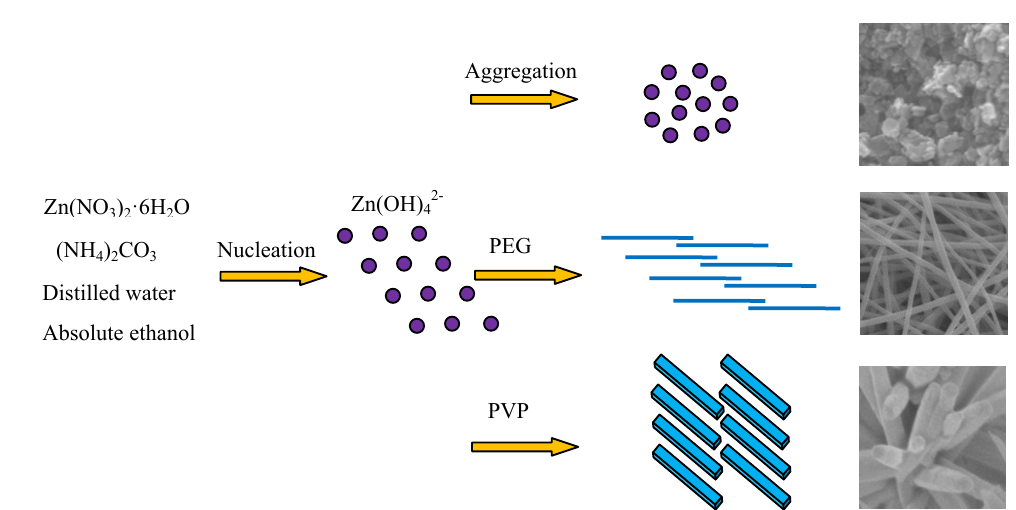
Figure 3. Schematic diagrams of the formation process of ZnO nanorods, nanofibers and